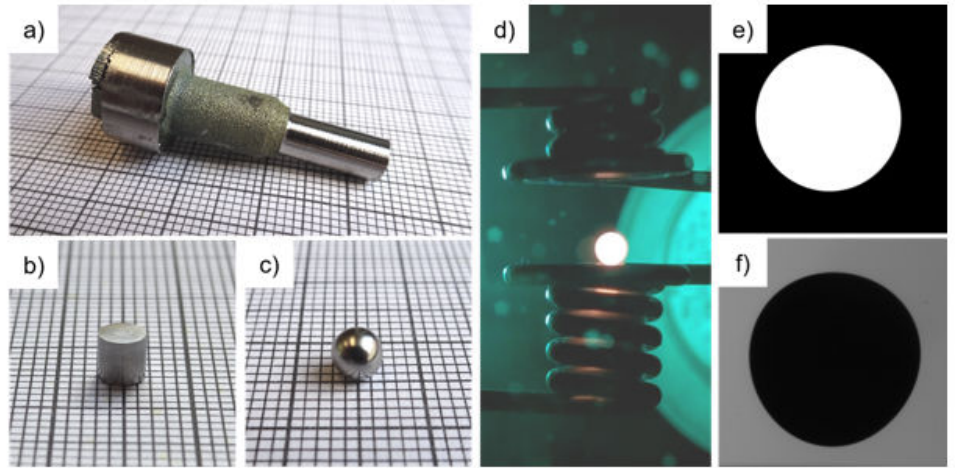
Figure A1. Pictures of the electromagnetic levitation (EML) samples (on graph paper) and the experiment itself. ( a ) Tensile test sample machined with a lathe, ( b ) prepared sample (small cylinder) cut from the tensile test sample, ( c ) sample after levitation, ( d ) sample during levitation (with background illumination), ( e ) image from surface tension measurement (top view) and ( f ) image from density measurement (side view).